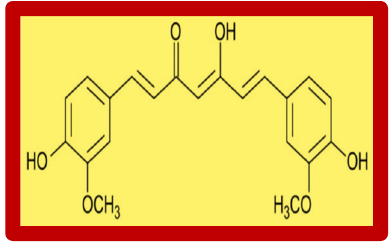
Figure 1. Chemical structure of curcumin.